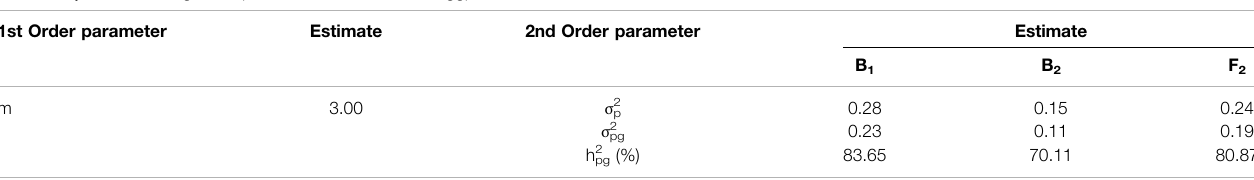
TABLE 1 | Estimates of genetic parameter of the TGW of